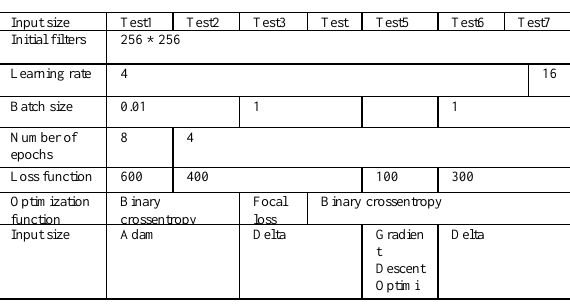
Table 1 . Summary of adjustment tests.